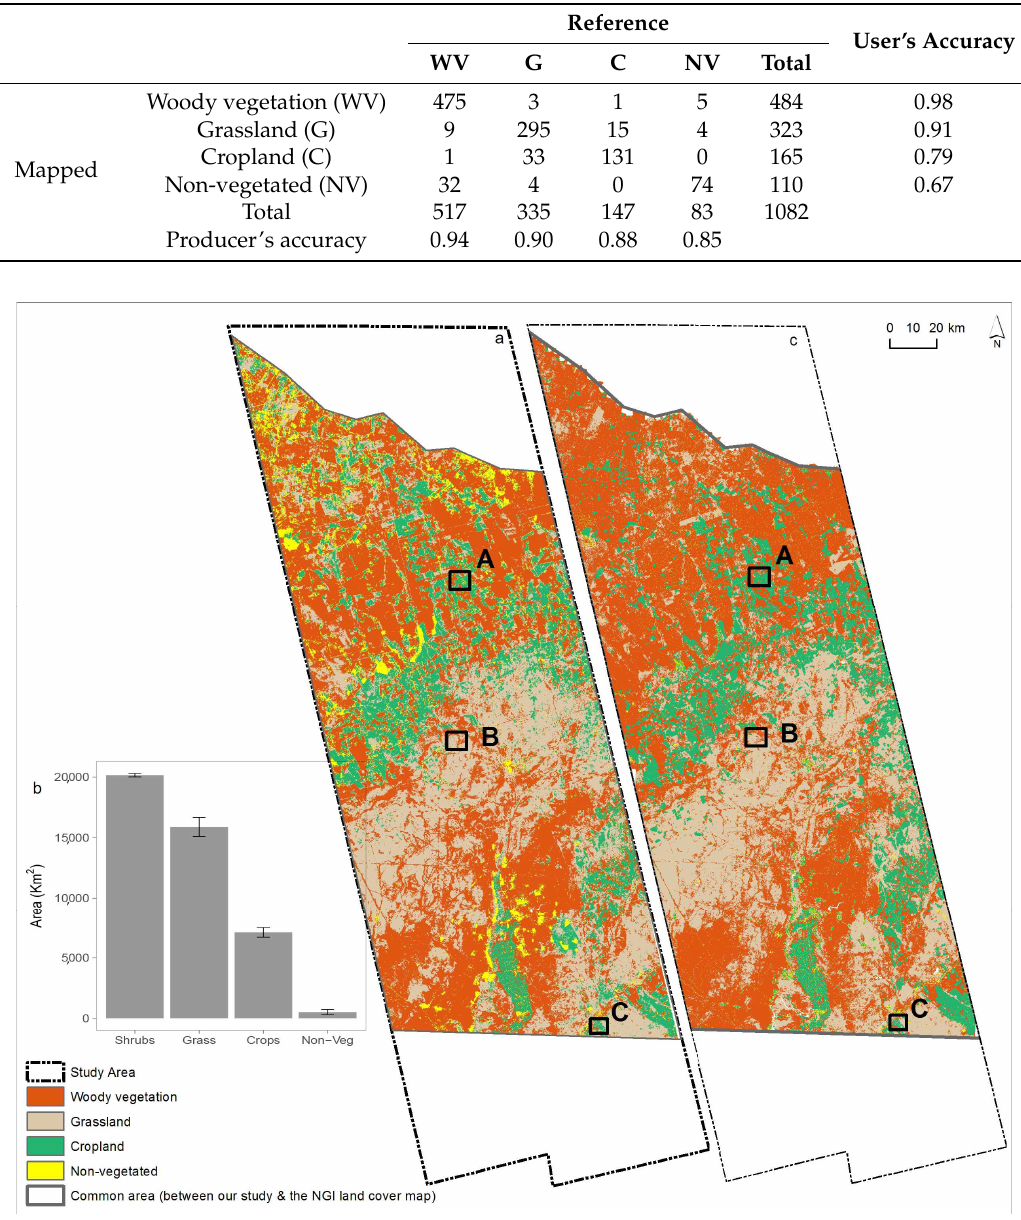
Figure 5. ( a ) Land cover map from the best performing model of this study (Model#9 in Table 3); ( b ) error-adjusted area estimates and 95% confidence interval margins for the four land cover classes estimated from the best performing model; and ( c ) the 2010 high resolution (SPOT 5 and colour infrared aerial photography-based) land cover data of the South African National Geospatial Information (NGI) mapping agency [43]. Locations A, B and C are the example subsets that appear